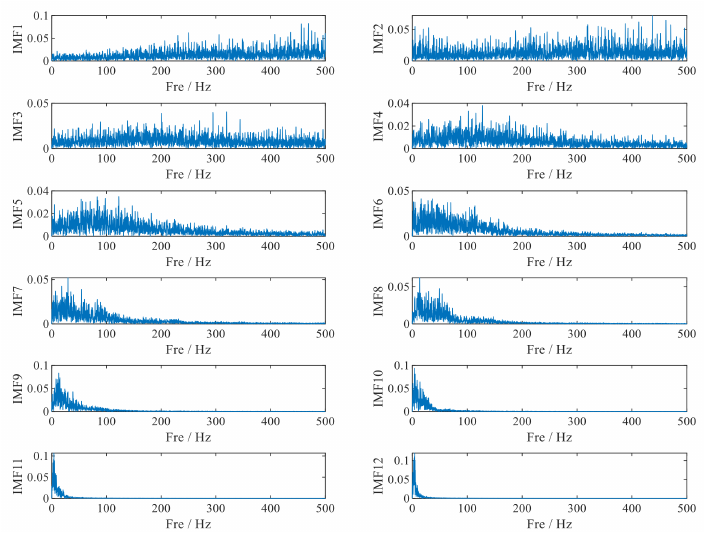
Figure 11. The result provided by proposed method using RV.